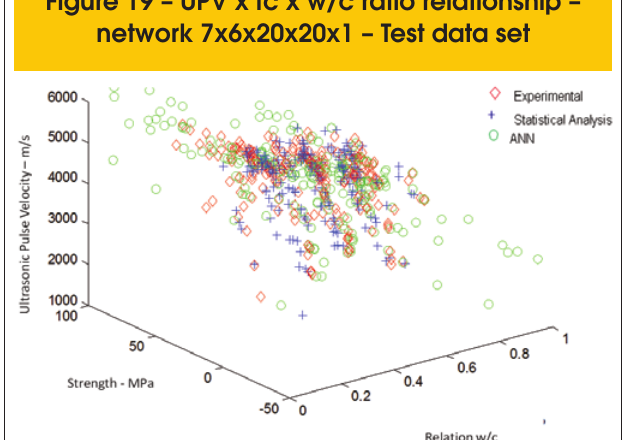
Figure 19 – UPV x fc x w/c ratio relationship – network 7x6x20x20x1 – Test data set